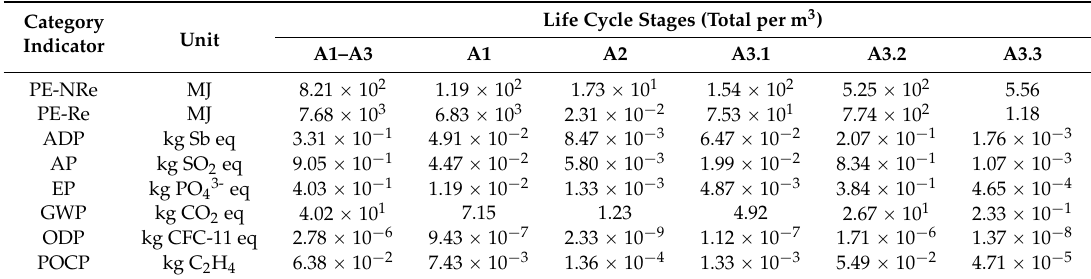
Table 4. LCA results for each sub-stage of the “product stage” (A1–A3) of one cubic metre of ICB (with a density of 110 kg/m 3 ). a density of 110 kg/m 3